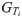
Variation in the number of nodes and links for the graphs of GTi.